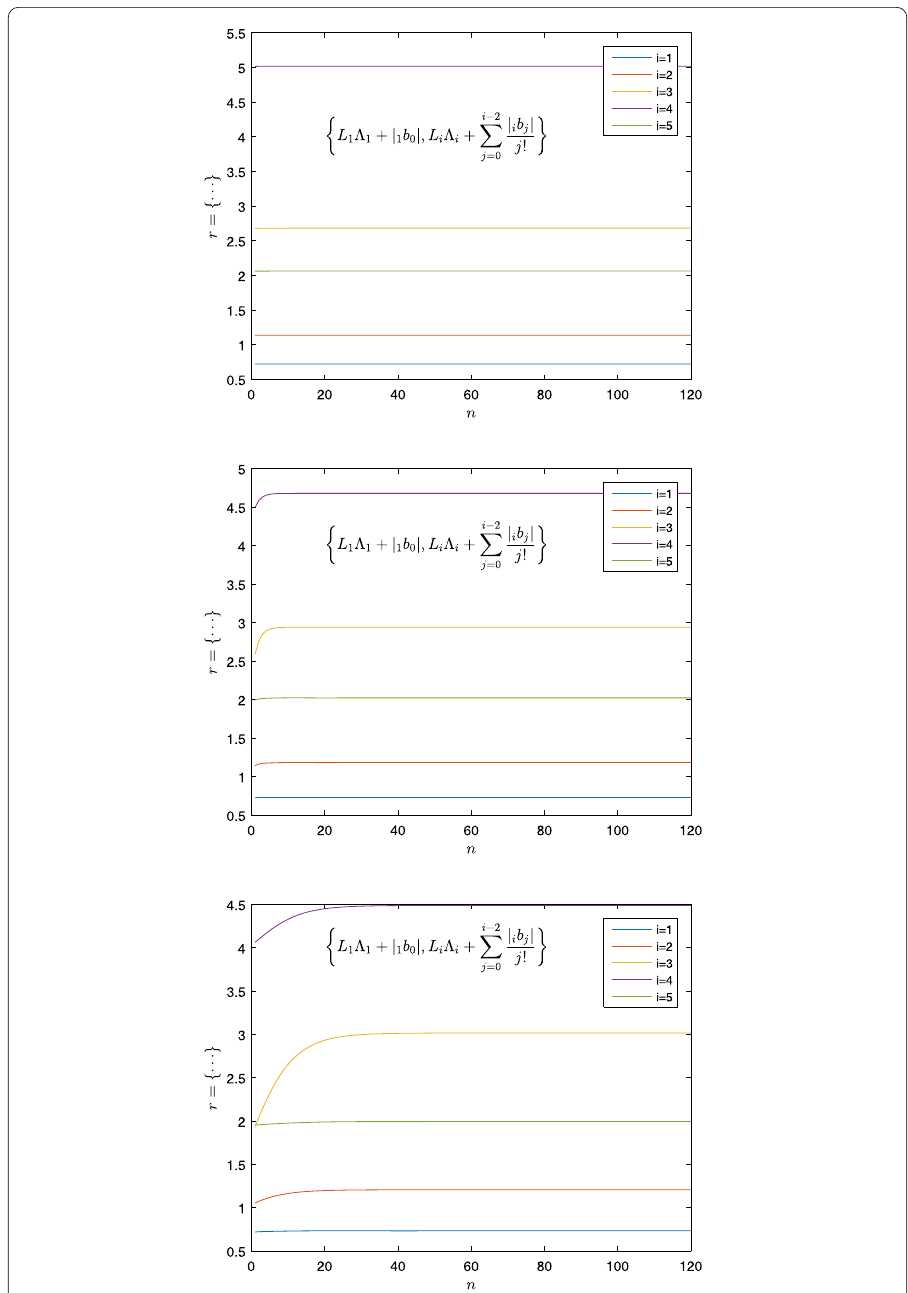
Figure 3 Numerical results of r for q = 1